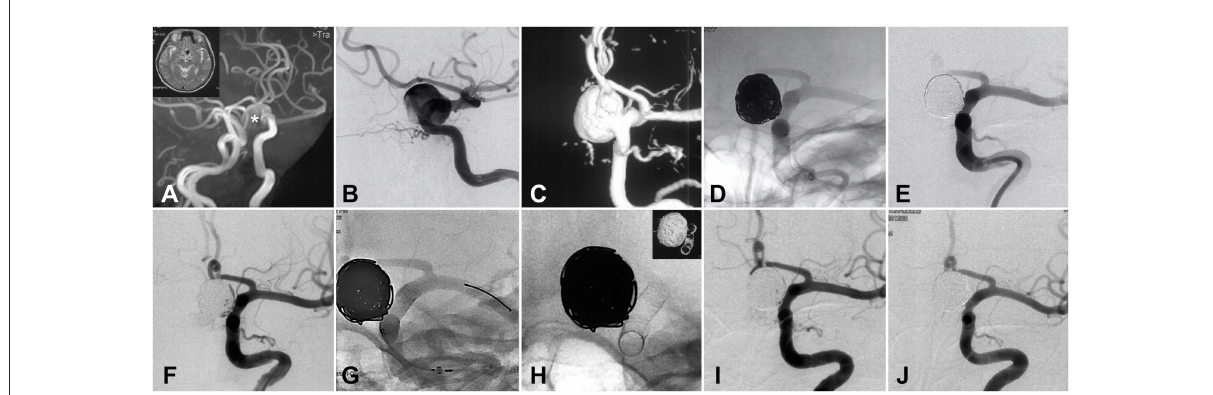
FIGURE2 Illustration of coiling and staged flow diverter treatment for a large intracranial aneurysm. (A) CT and CT angiography identified the giant internal carotid aneurysm. (B) DSA confirmed the size and location of the aneurysm. (C) Three-dimension re-construction of the DSA. (D) First-stage coiling of the giant aneurysm. (E) Angiography after first-stage coiling. (F) DSA image right before the staged flow diverter (FD) treatment. (G) The procedure of FD implantation. (H) The shape and location of the implanted FD. (I) Angiography immediately after FD implantation. (J) Six-month follow-up DSA showed the complete occlusion of the giant aneurysm. *The position of aneurysm